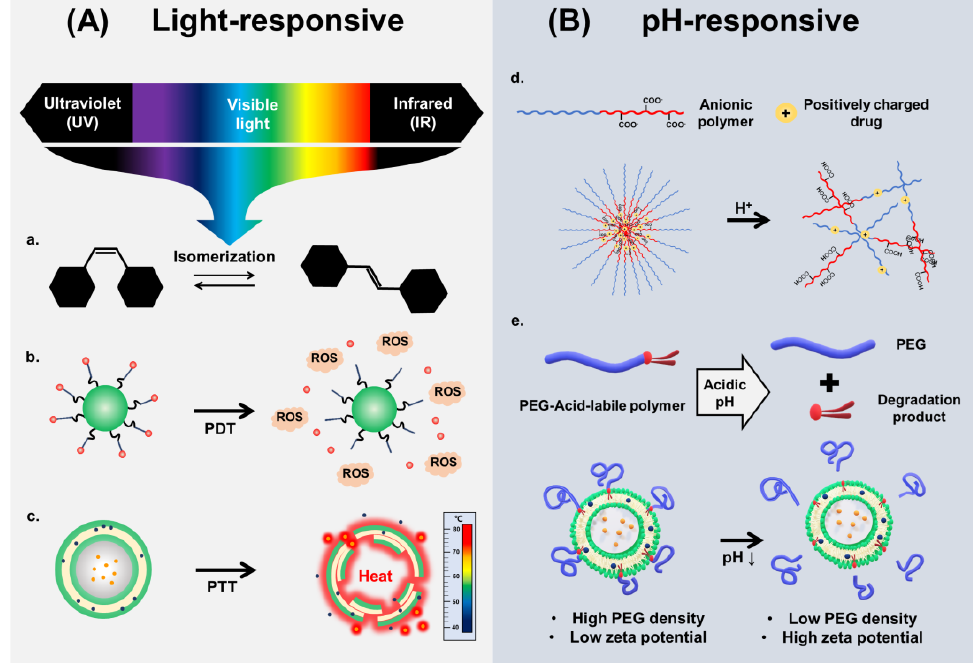
Scheme 1. Schematic illustration of the concept of ( A ) light- or ( B ) pH-responsive drug